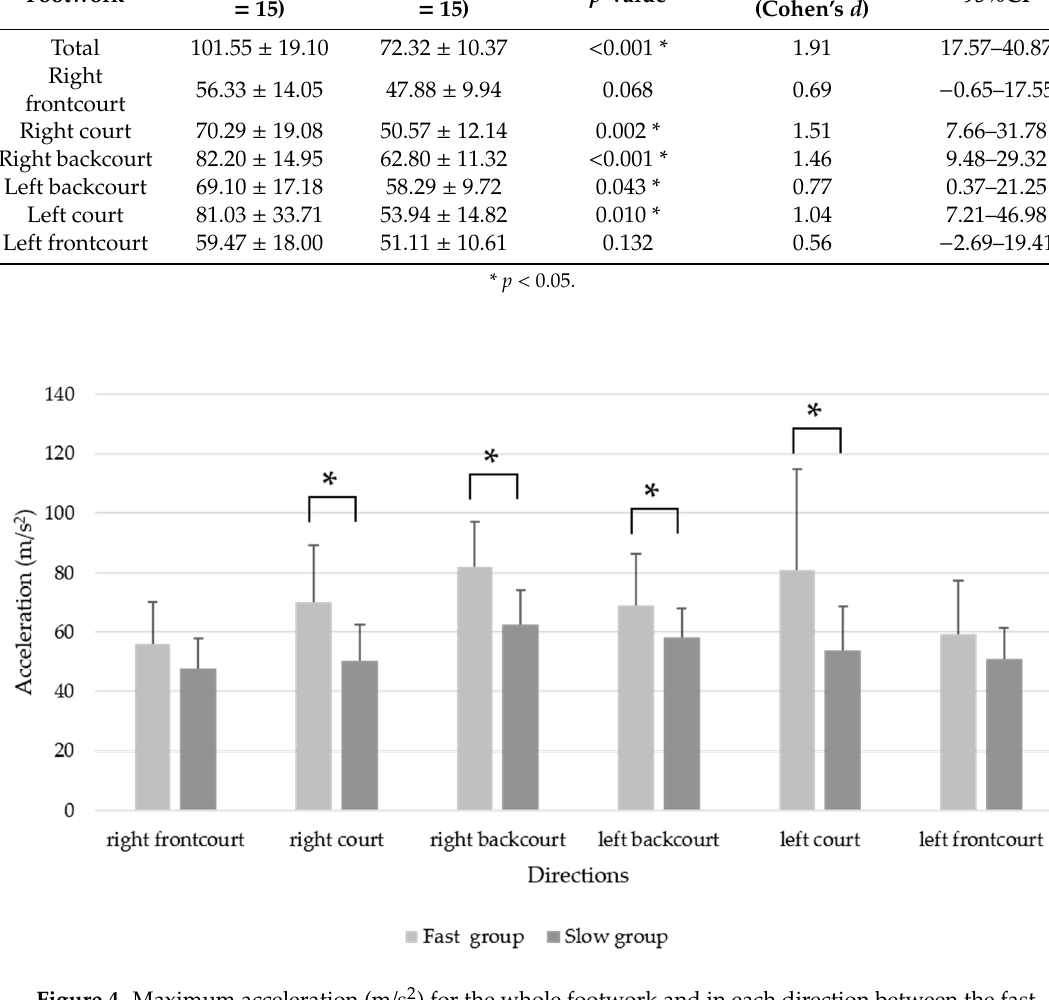
Table 3. Maximum acceleration (m / s 2 ) for the entire footwork task and in each direction for the fast and slow groups. Mean ± standard deviation.